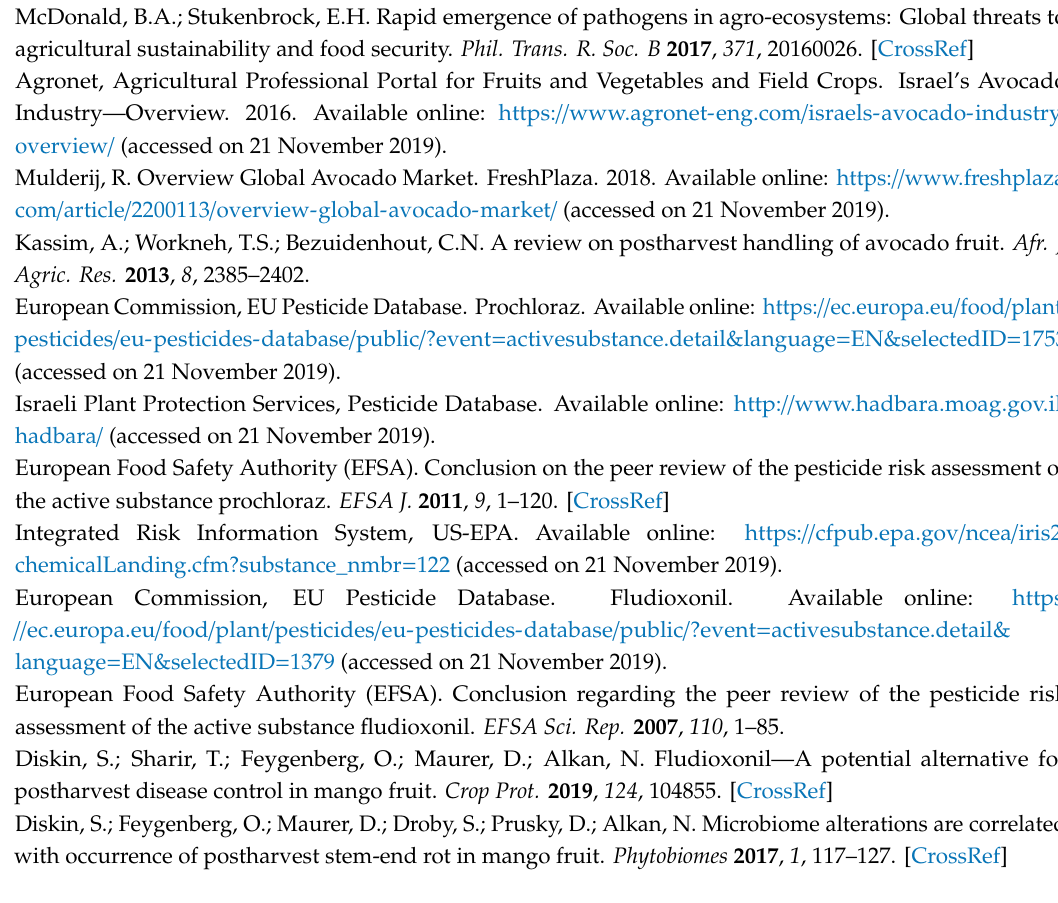
Table S1: Fruit quality parameters, Table S2: Decay occurrence after cold storage in avocado fruit, Table S3: Linear regression F -test of peel pesticide concentration vs. time, Table S4: Calculated total concentrations of prochloraz, its metabolites, and fludioxonil in whole fruit